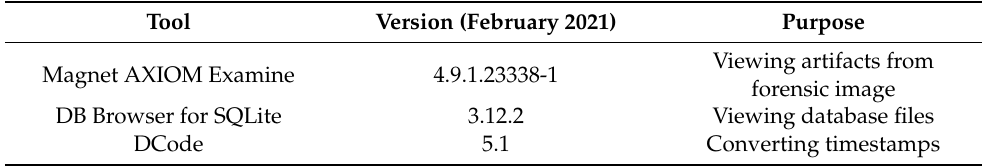
Table 2. Summary of software tools used during the analysis